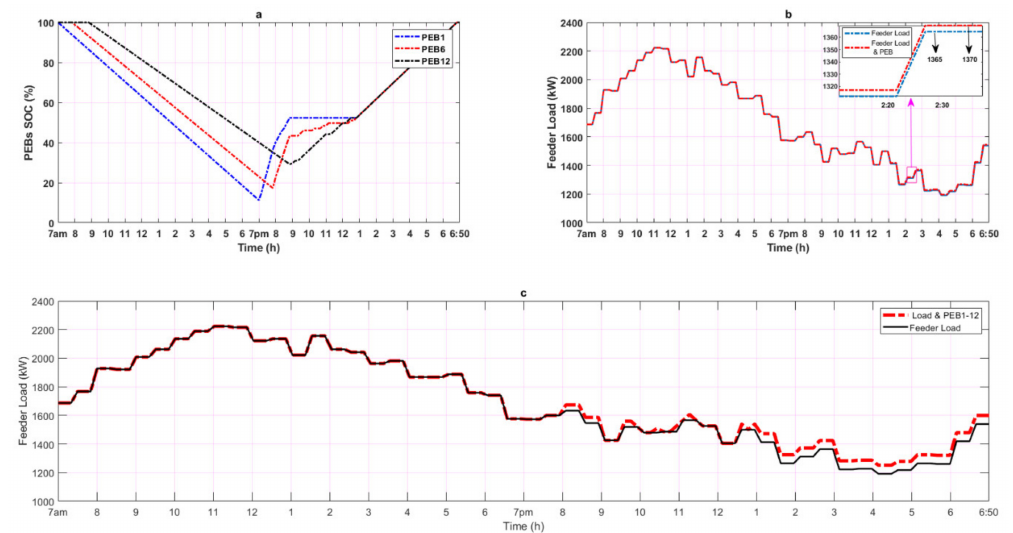
Figure 6. Coordinated and limited charging: (a) SOC of three PEBs; (b) impact of charging three PEBs; and (c) impact of charging 12 PEBs on the LV